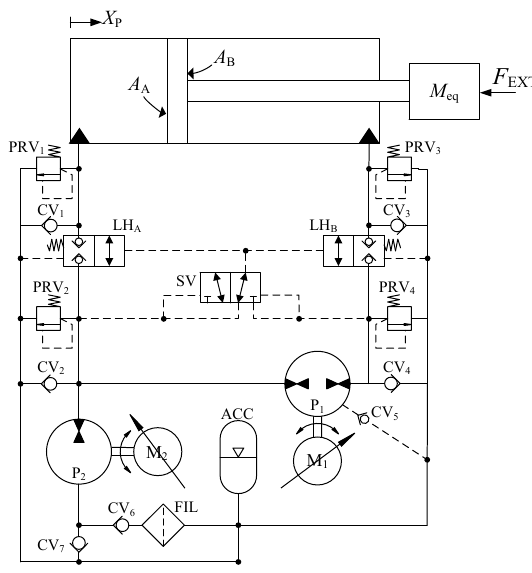
Figure 1: Asymmetric cylinder controlled by the dual variable-speed pump (DvSP)